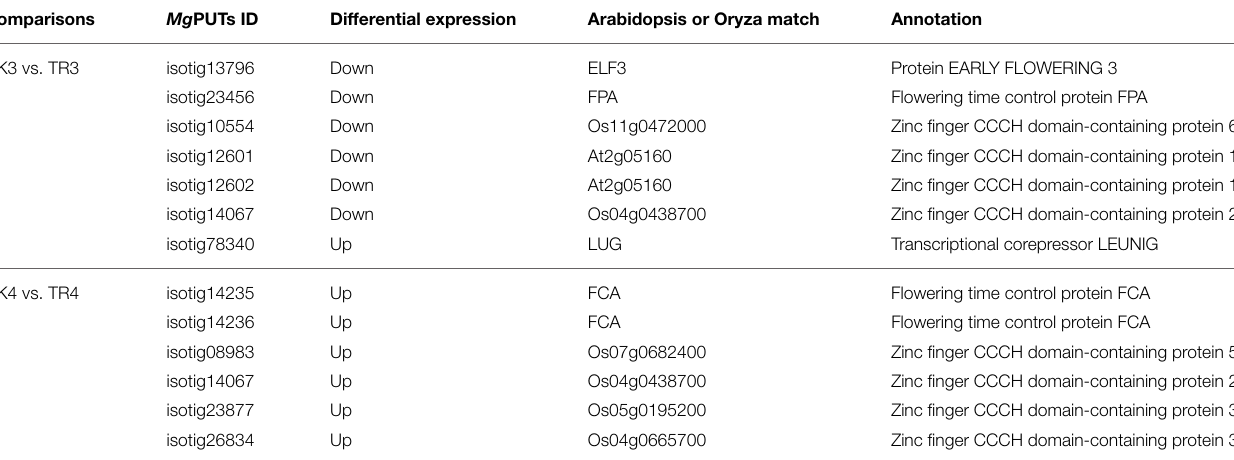
TABLE 3 | Twelve differentially expressed genes identified in hormone-treated shoots undergoing female bud initiation. Comparisons